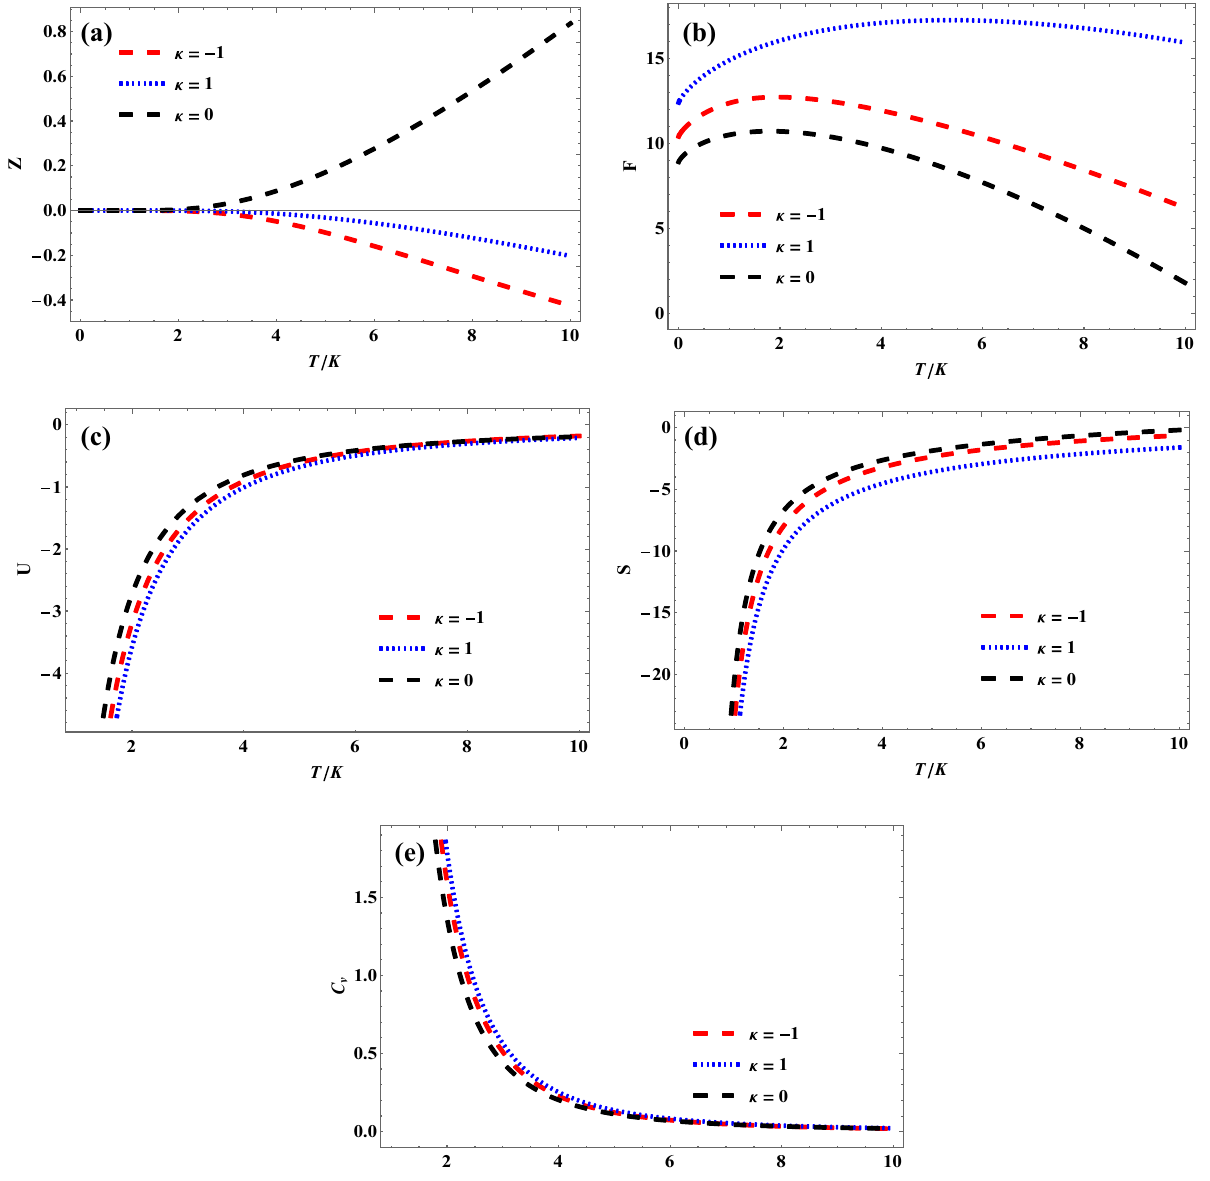
Figure 2. ( a ) Variation of partition function of quantum pseudoharmonic oscillator with temperature for selected κ -values. ( b ) Variation of free energy of quantum pseudoharmonic oscillator with temperature for selected κ -values. ( c ) Variation of internal energy of quantum pseudoharmonic oscillator with temperature for selected κ -values. ( d ) Variation of entropy of quantum pseudoharmonic oscillator with temperature for selected κ -values. ( e ) Variation of specific heat capacity of quantum pseudoharmonic oscillator with temperature for selected κ